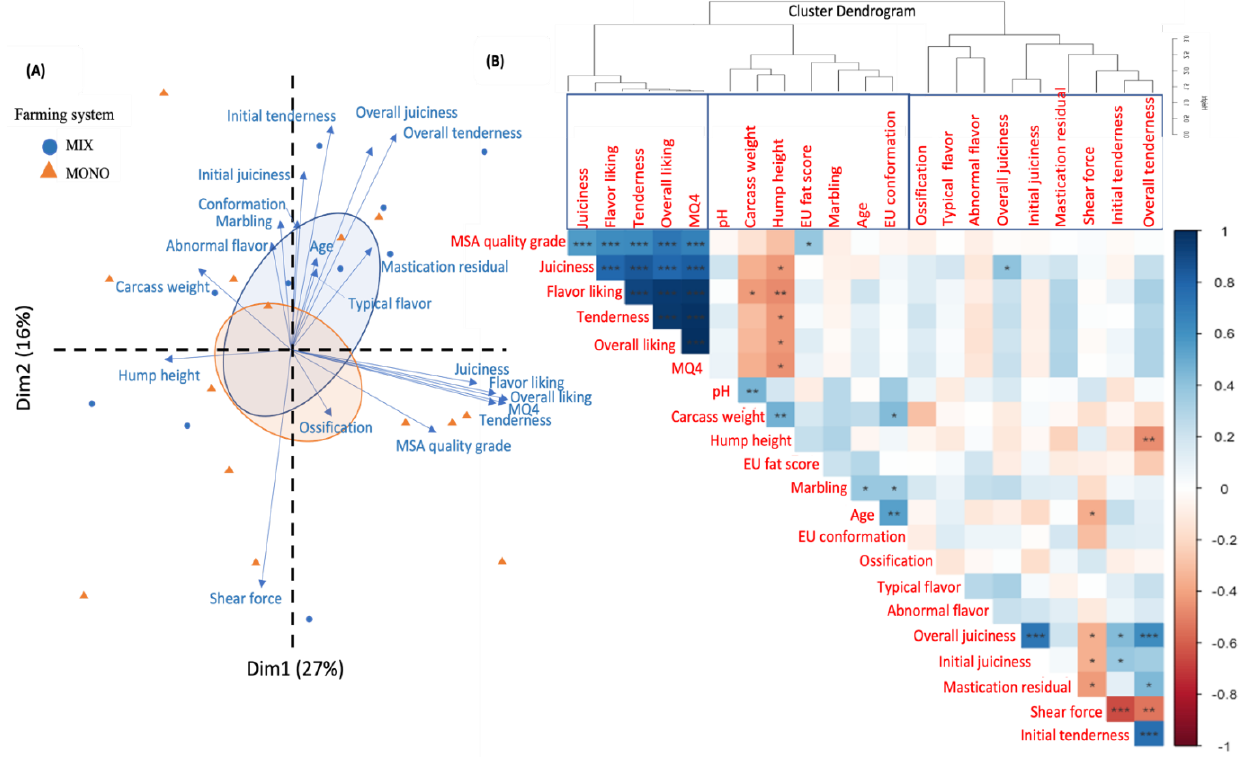
Figure 1. ( A ) Principal component analysis (PCA) and ( B ) Pearson correlation matrix with hierar- chical cluster analysis (HCA) of animal and carcass characteristics and meat eating quality (14-day-aged striploin). *: p < 0.05; **: p < 0.01; ***: p < 0.001.